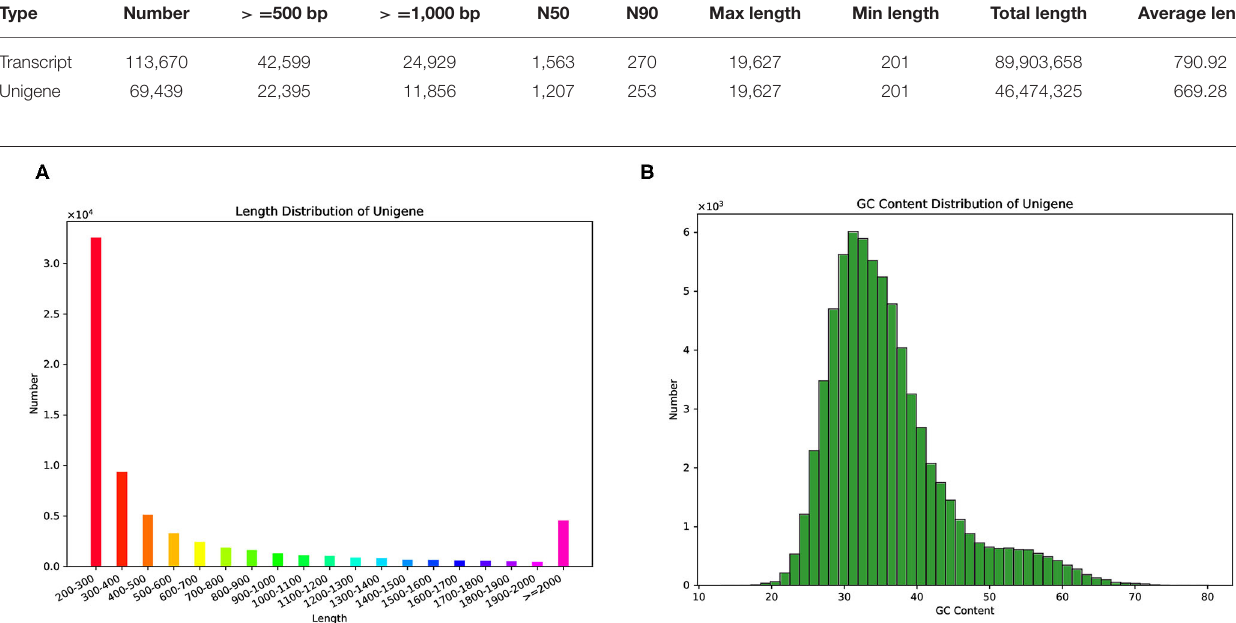
TABLE 2 | Transcriptome assembly results.